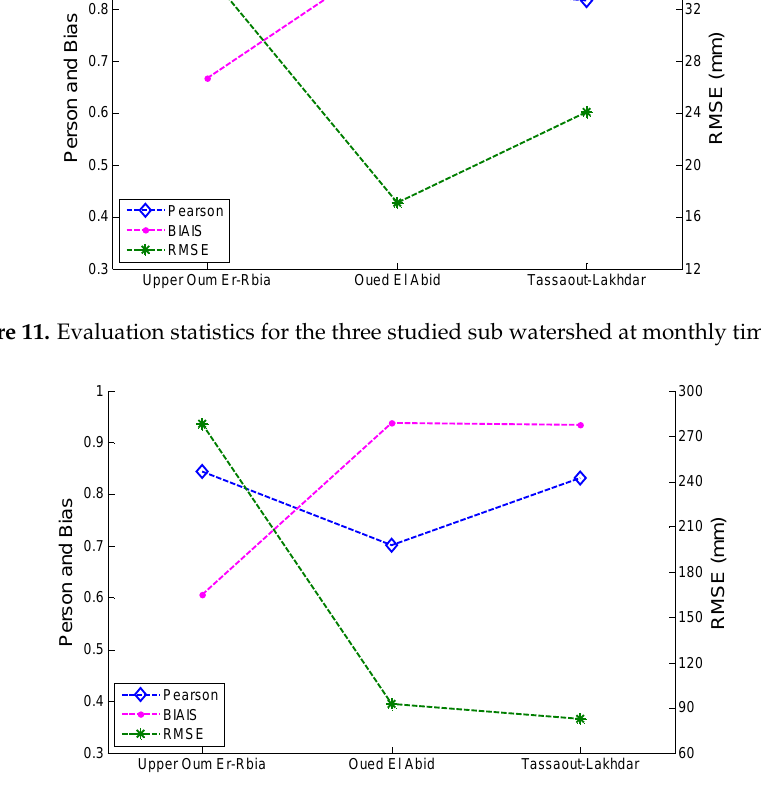
Figure 12. Evaluation statistics for the three studied sub-watershed at annual time scale.